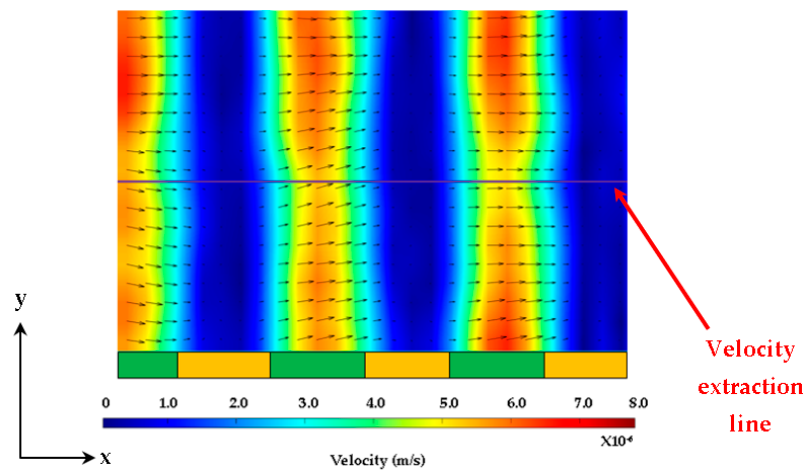
Figure 20. Velocity contour of 10 particles moving between the electrodes at 10 Hz and with a large electrode spacing. The electrode ( gold ) and spacing ( green ) are shown below the figure.